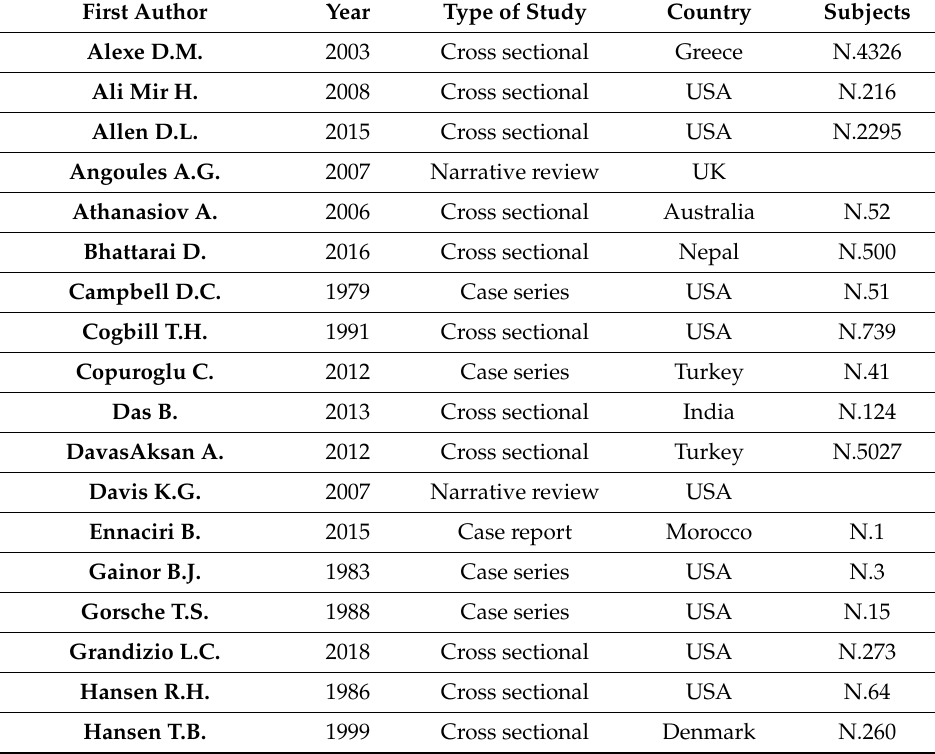
Figure 4. Bibliographic research flow chart. Table 1. Included studies in systematic review.